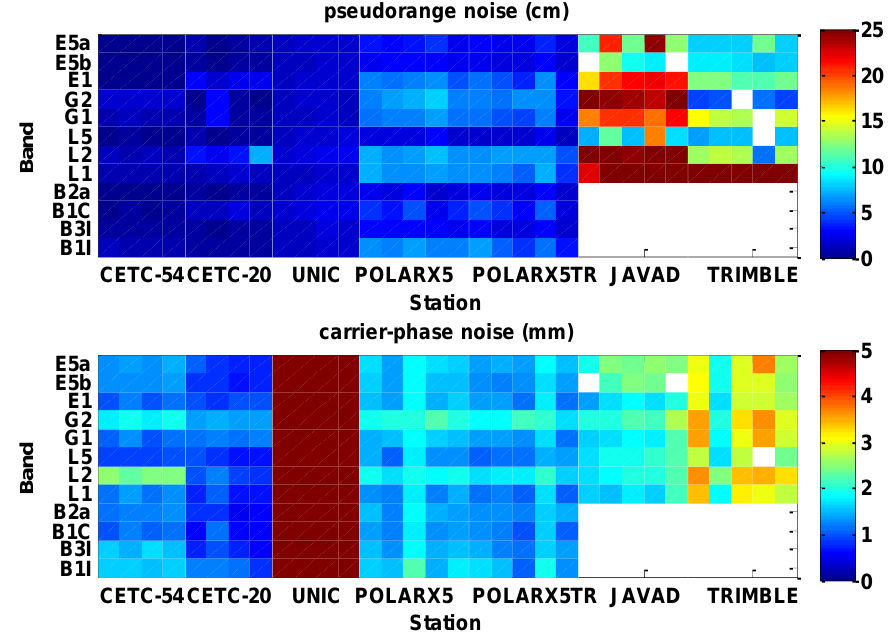
Figure 4. Mean pseudorange and carrier-phase noise of stations analyzed by triple-differenced method for 80 days. Different types of receivers are separated by white lines.